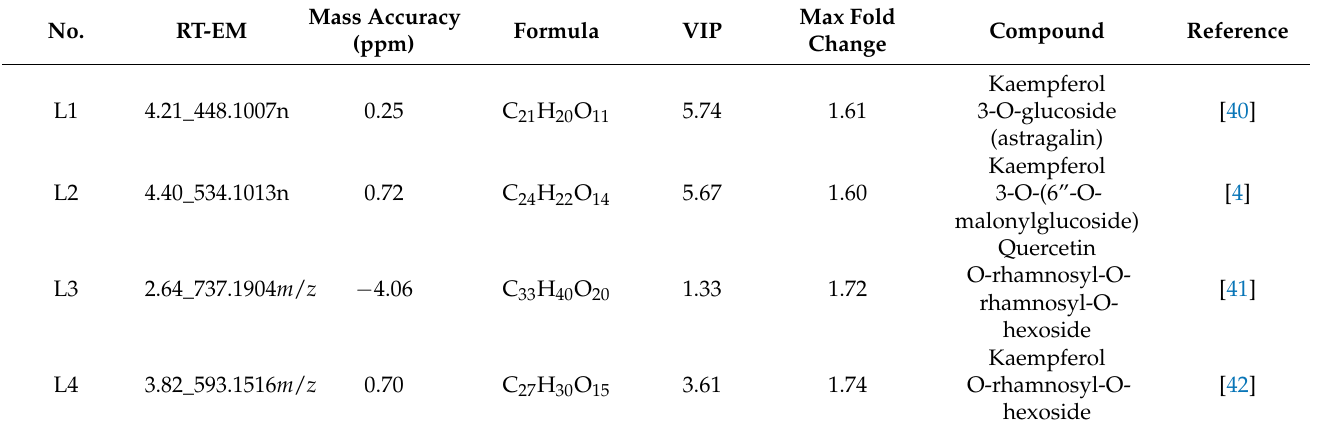
Table 1. Differential metabolites for male and female leaves, filtered with VIP > 1, | p | ≥ 0.05 and | p (corr)| ≥ 0.5, ANOVA p value ≤ 0.05, and max fold change ≥ 1.5.